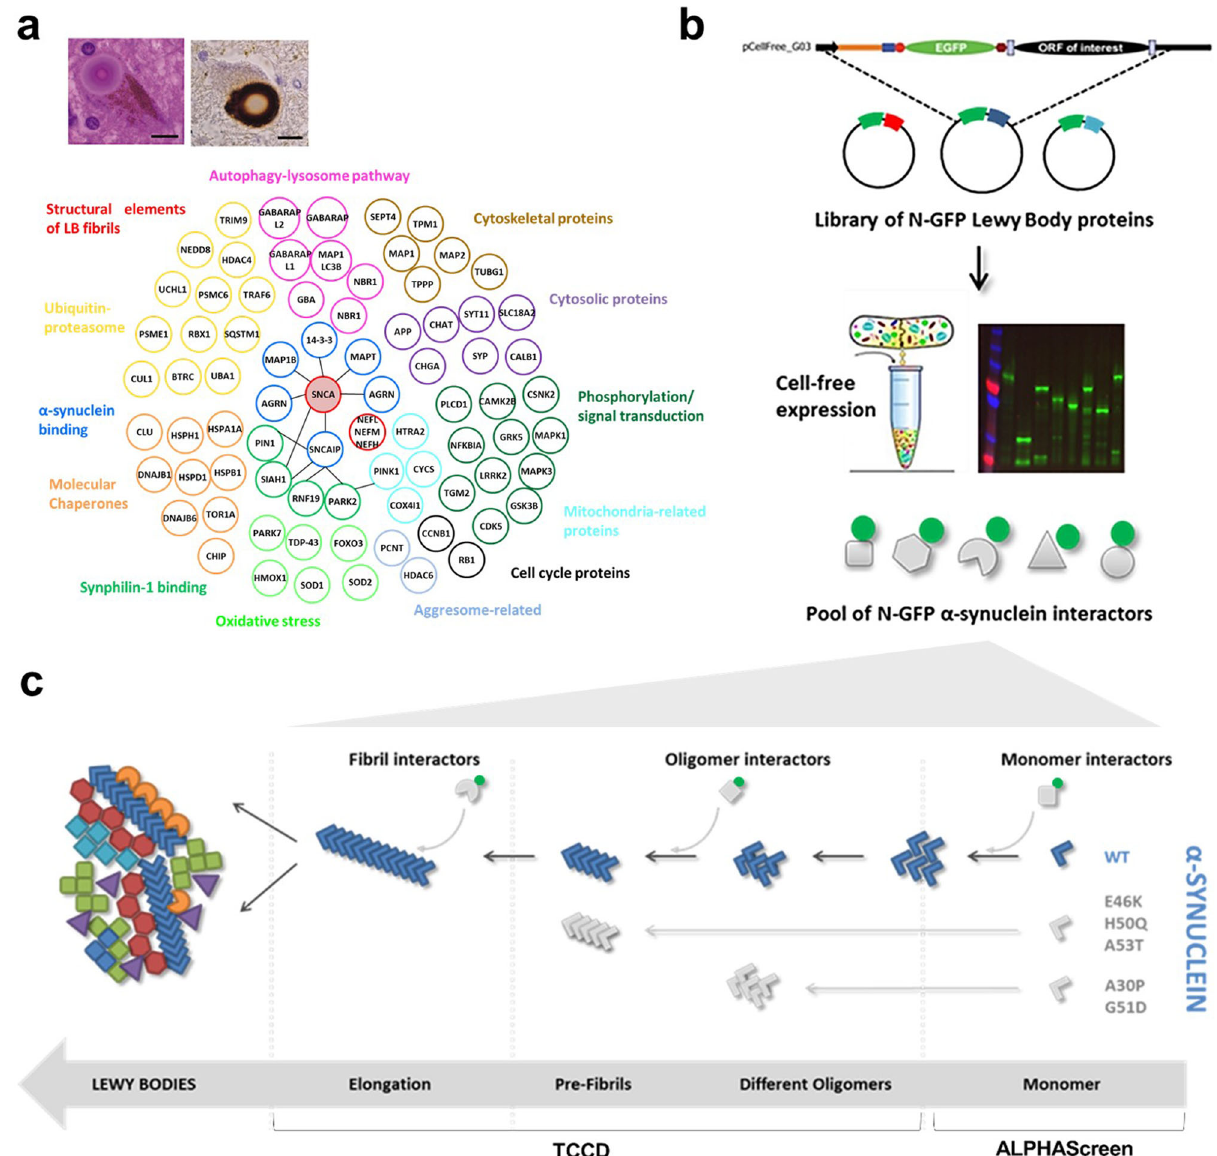
Fig. 1 Experimental set-up to understand the formation of the Lewy bodies by measuring protein – protein interactions along the aggregation cascade of α -SYN. a The Lewy bodies contain >80 different proteins, which are involved in several cell processes. Inset adapted from Brown et al. 9 . b By using a Gateway cloning system, a library of N-terminal GFP-tagged Lewy body proteins was acquired for expression in the cell-free Leishmania tarentolae lysate. c On pathway to its inclusion in the Lewy bodies, the aggregation of α -SYN is known for comprising different steps. Upon misfolding of its monomeric form, α -SYN self- assembles into oligomeric, pre- fi brillar and fi brillar forms, respectively. Three different assays were designed to identify the main interactors of α -SYN in four of its forms along this cascade: monomeric (AlphaScreen), oligomeric, pre- fi brillar, and fi brillar (two-colour coincidence detection using a single-molecule spectroscopy interaction) and 1 (maximal interaction) (Fig. 2c). Most proteins were found to be only weak binders of α -SYN; however, three proteins emerged as interactors of N-mCherry-tagged α -SYN, when statistically compared to the negative control of monomeric GFP. These interactors include two kinases: G-protein receptor kinase 5 (GRK5) and mitogen-activated protein kinase 1 (MAPK1); and a component of the ubiquitin – proteasome system: proteasome activator complex subunit 1 (PSME1) (Fig. 2c, d). As a control, α -SYN itself was identi fi ed as a binder, in agreement with our previous data 7 . We note that the hit rate of the AlphaScreen experiment is much lower than typically observed in our previous protein – protein interaction screens 9 – 11 .